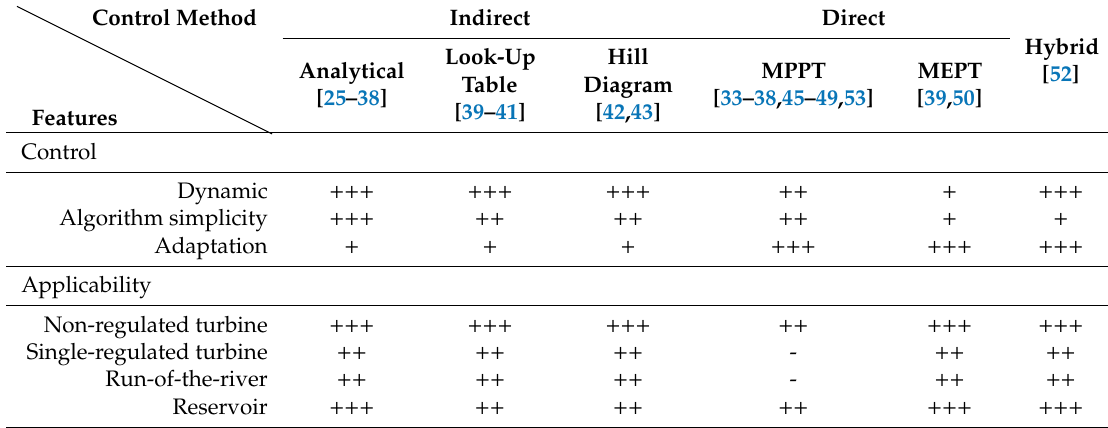
Table 1. A comparison of the control methods for SHPs with variable speed operation.